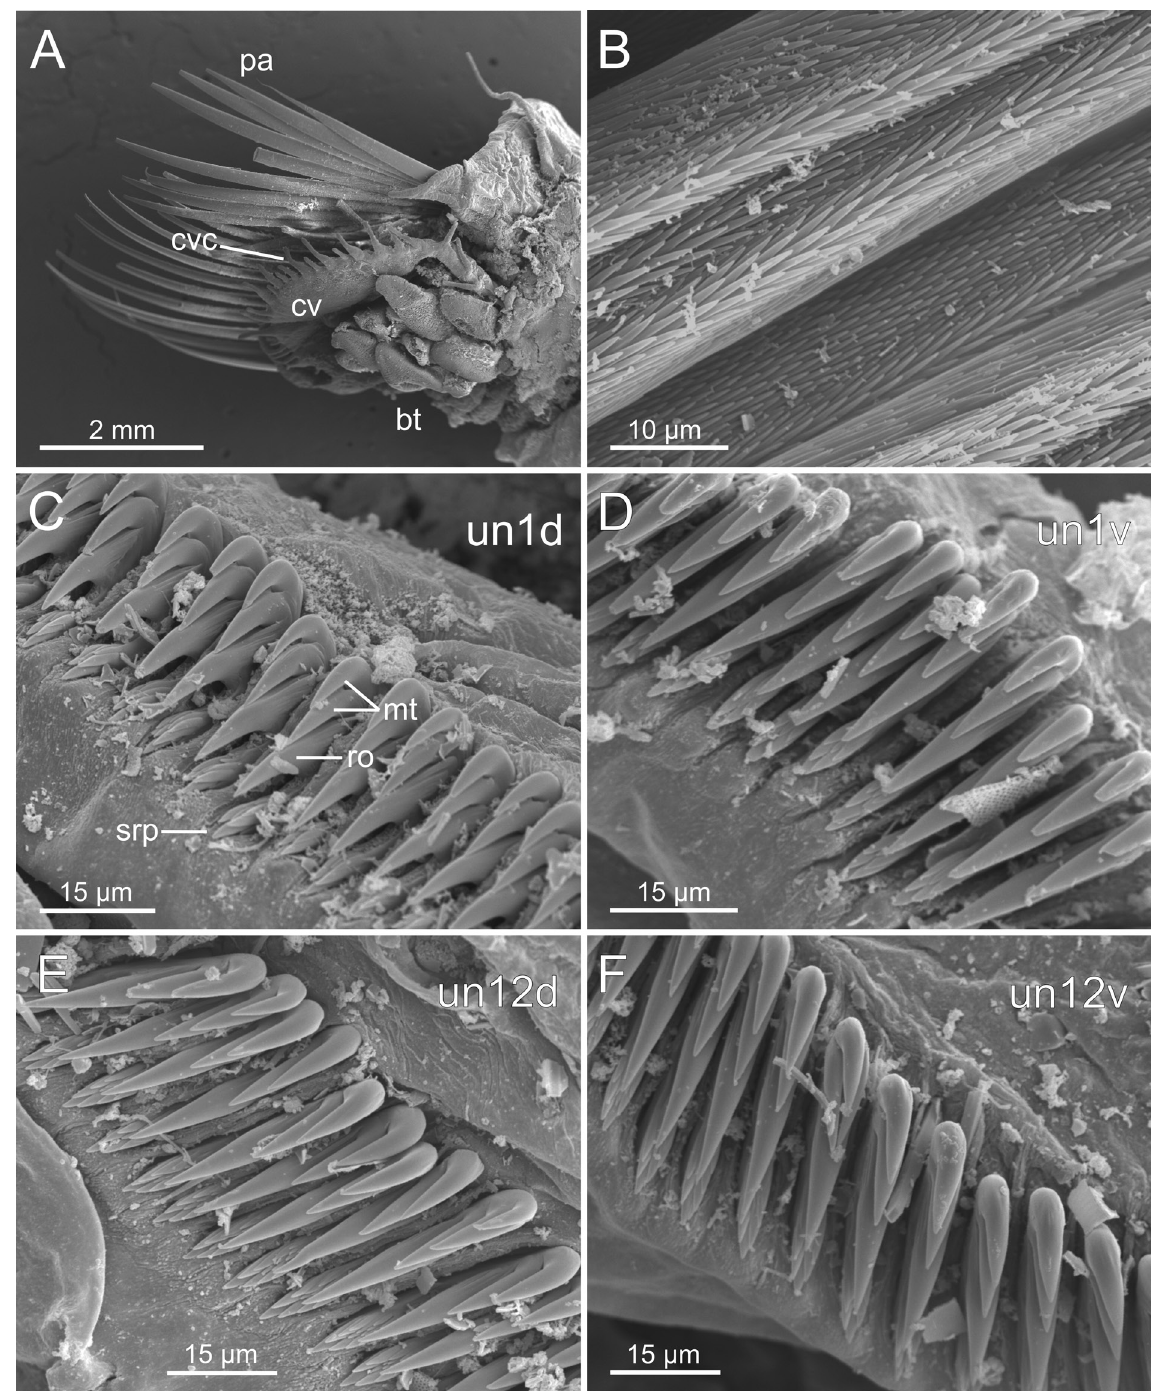
Fig. 10. Cistenides hyperborea Malmgren, 1866. SEM micrographs from three large specimens (BIOICE sample 3252, IINH-40477). A . Anterior end, left ventrolateral view. B . Notochaetal scale covering, detail. C–D . Unciniger 1, dorsal and ventral uncini, respectively. E–F . Unciniger 12, dorsal and ventral uncini,